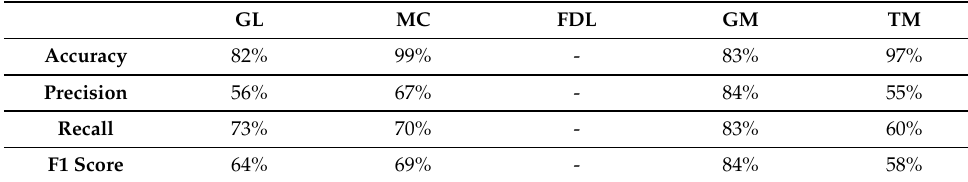
Table 10. Performance metrics for final SSD ResNet50 model on the test set, using a score threshold of 0.05 and 0.1 NMS threshold.